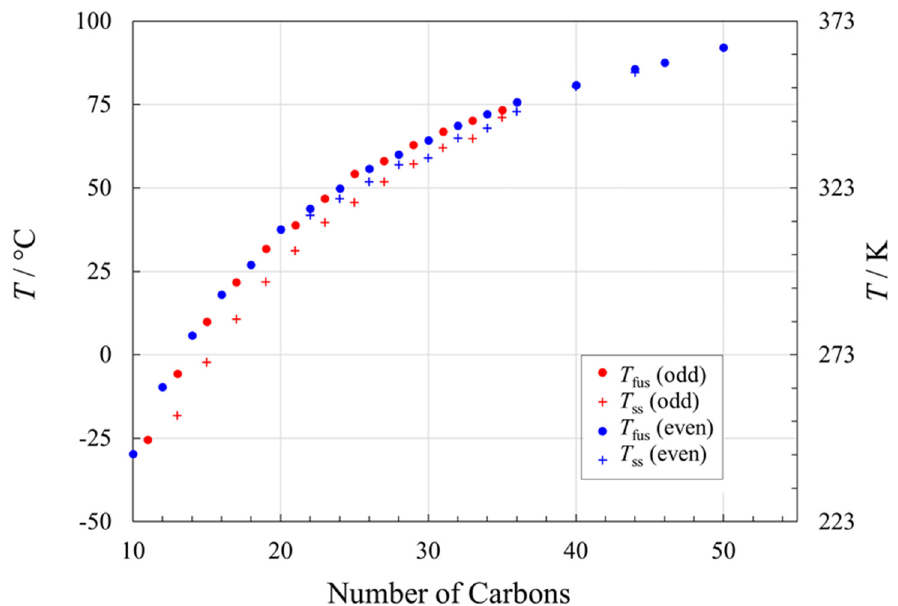
Figure 2. Phase transitions in n -alkanes (paraffins) as a function of chain length, n . Circles ( • for even n ; • for odd n ) represent melting temperatures, and crosses (+ for even n ; + for odd n ) represent the temperatures of the main solid–solid transition, if present. See Supplementary Information for data and data sources.